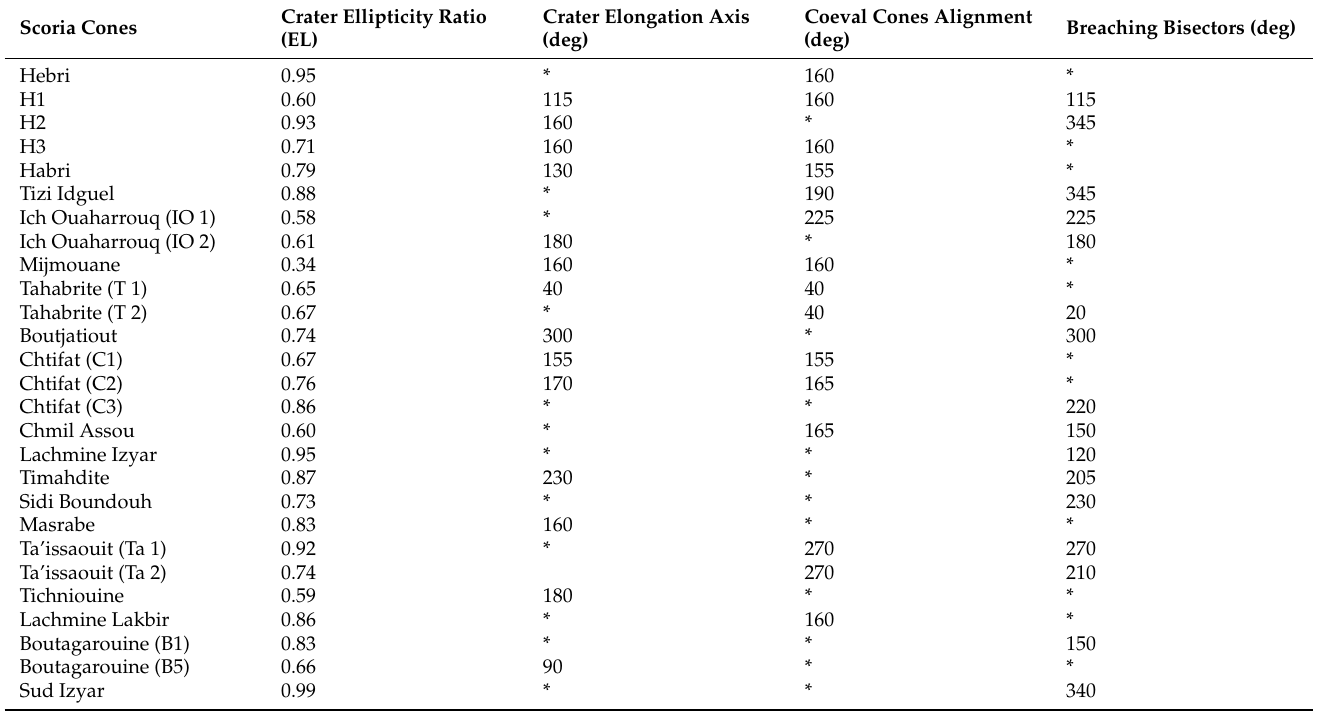
Table 3. Morphometric data of volcanoes in MAVF. Not